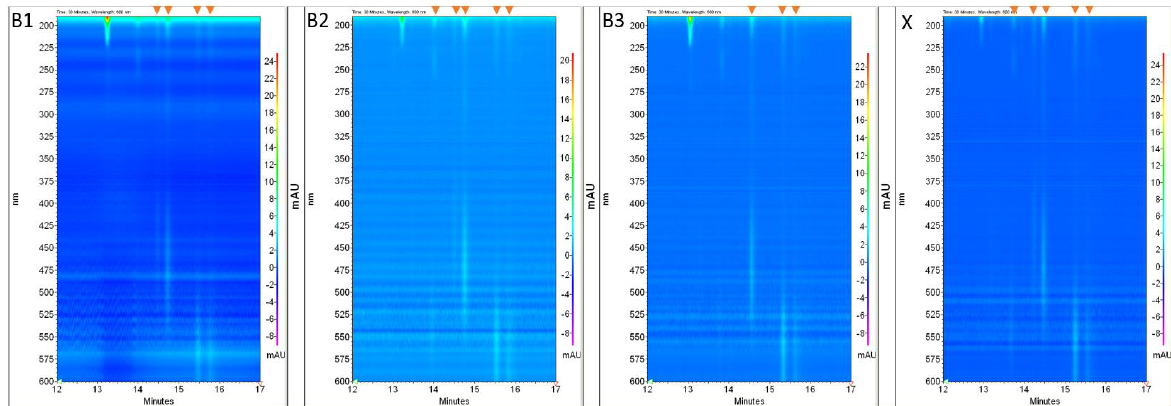
The ranges of Vis radiation absorption were detected using photodiode array detec- tion (PDA). The fragments of PDA electropherogram views showing the dye signals are presented in Figure 4 and the electropherograms at 220 nm are in Figure 5.